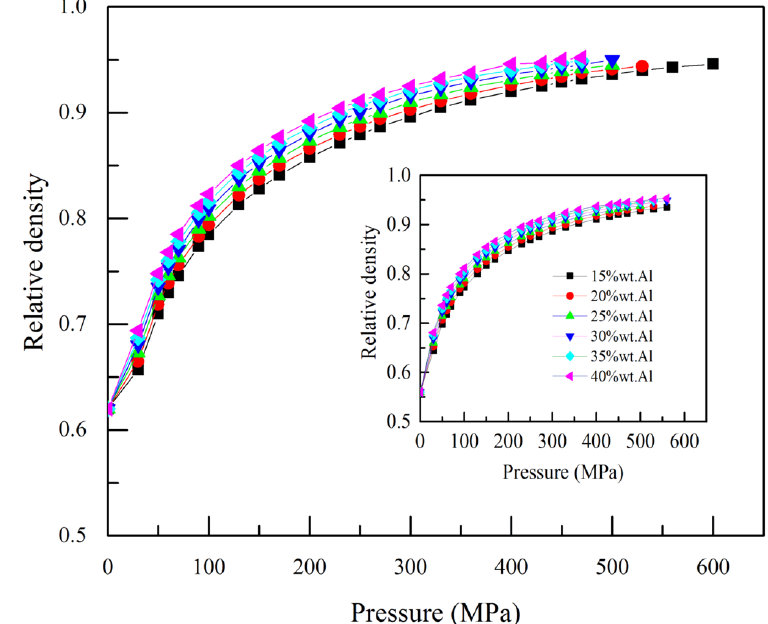
Figure 9. Evolution of average relative density with compaction pressure for dense (main plot) and loose (inset) initial packing structures.